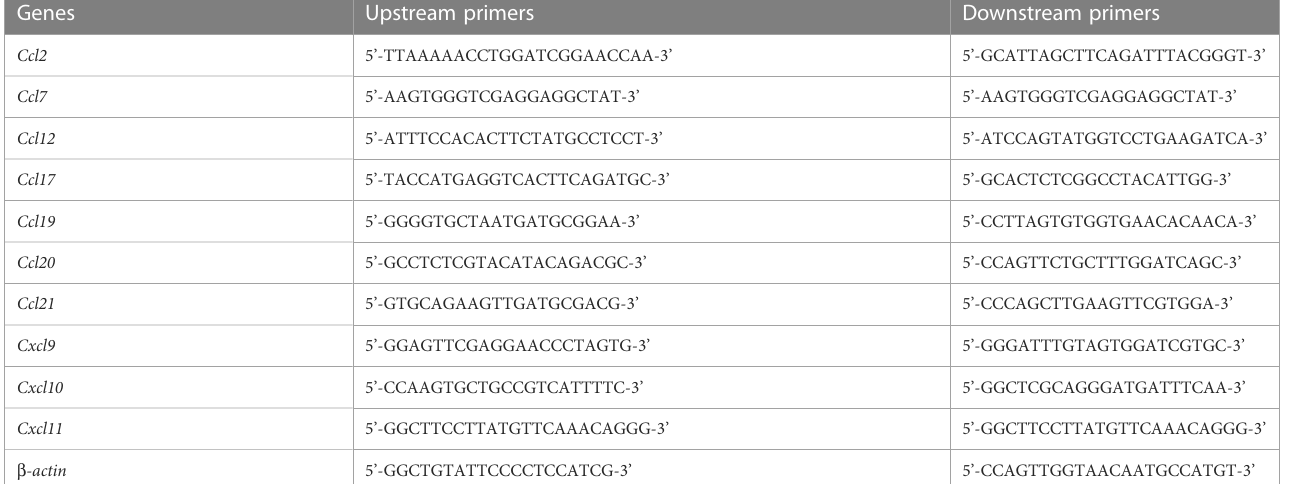
TABLE 2 The primers for chemokines. Genes Upstream primers